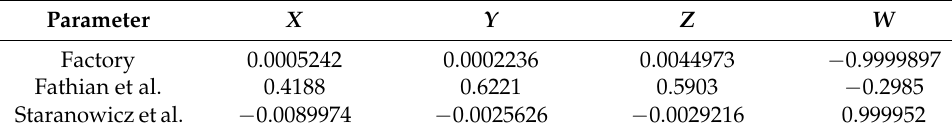
Table 3. Depth camera (RGB-D) rotation parameters.